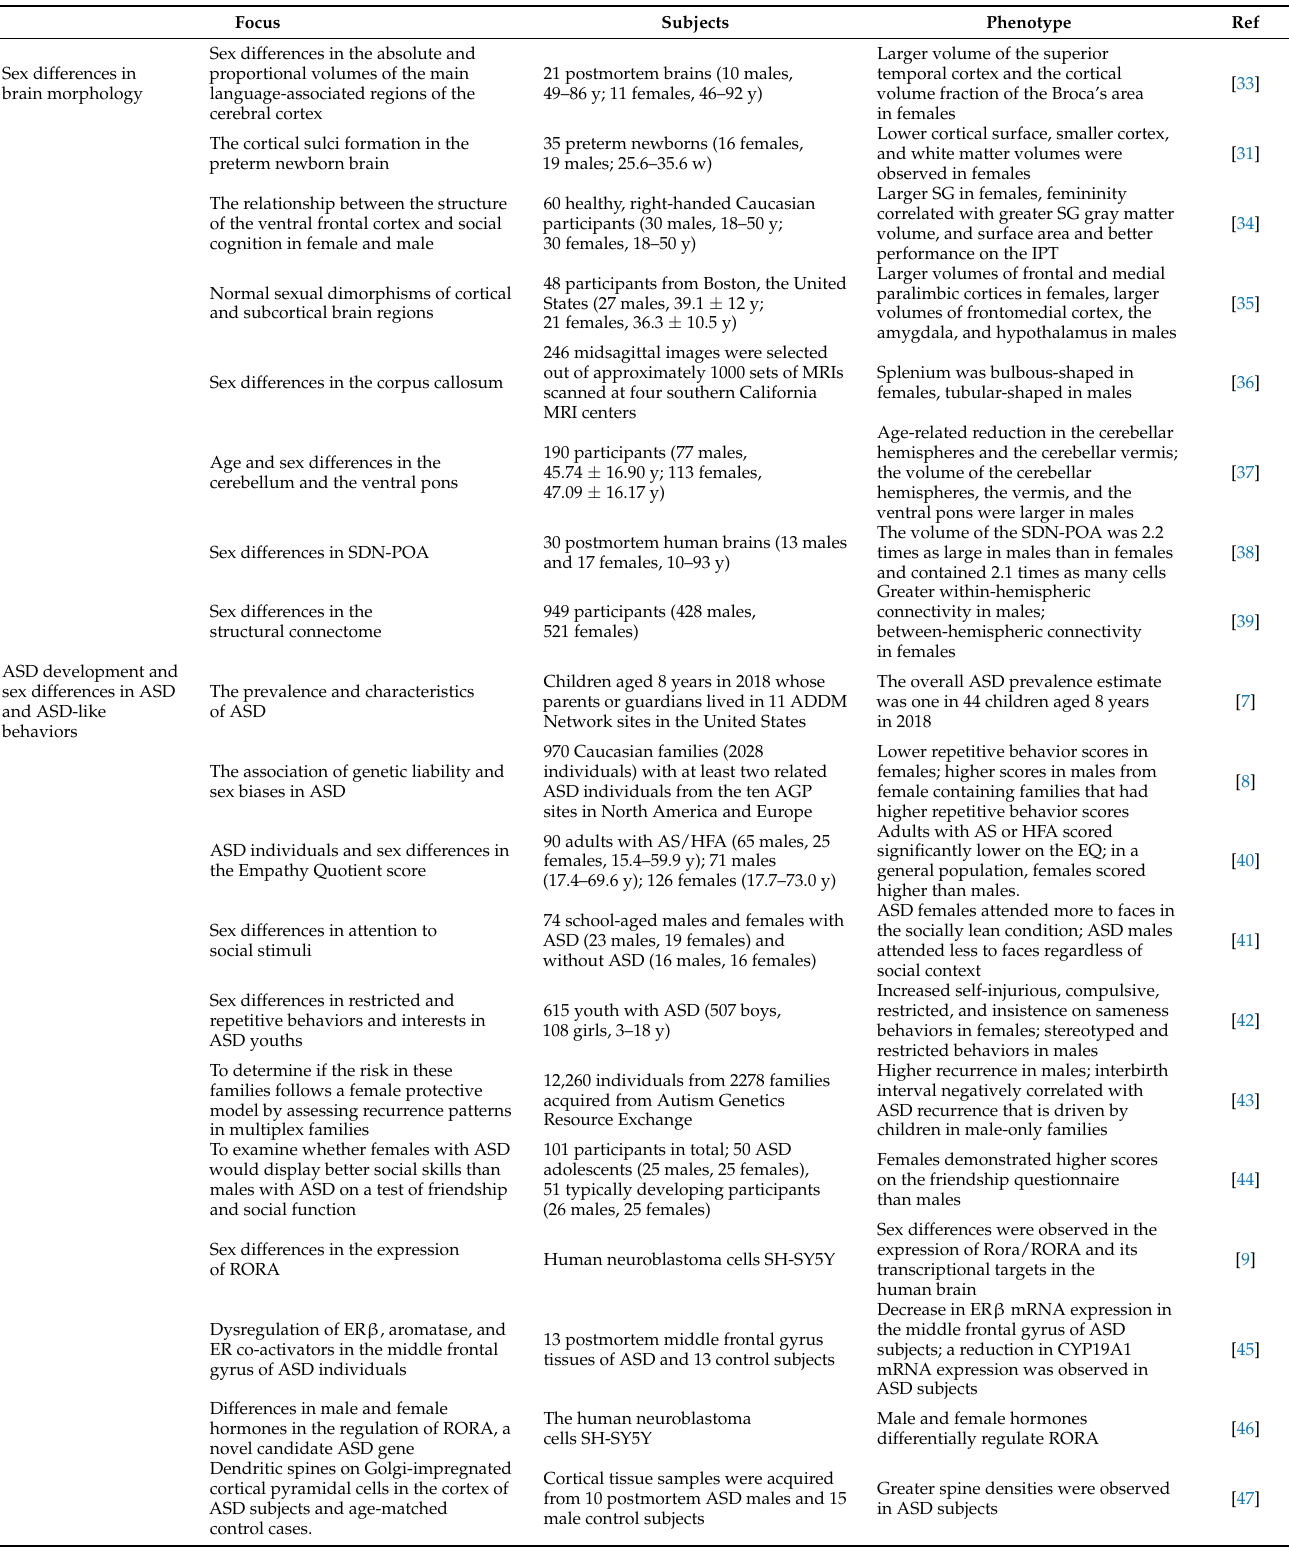
Table 1. Summary of human studies on sex differences and